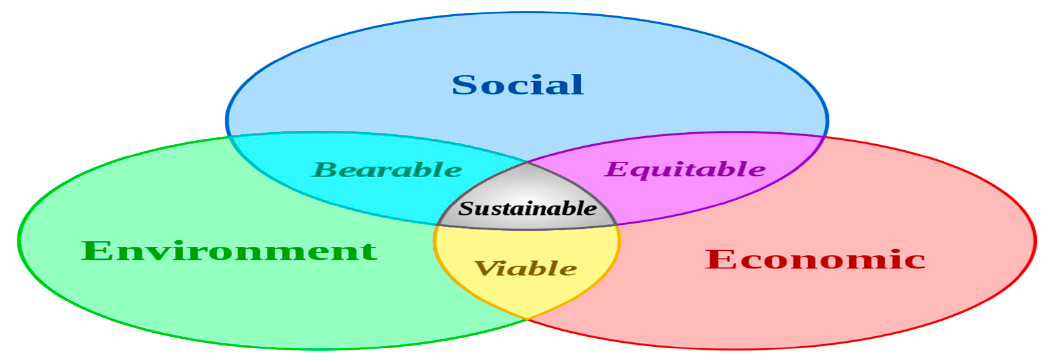
Figure 5. Model of “Sustainable Development” [8]. Source: Richard Howarth [8].